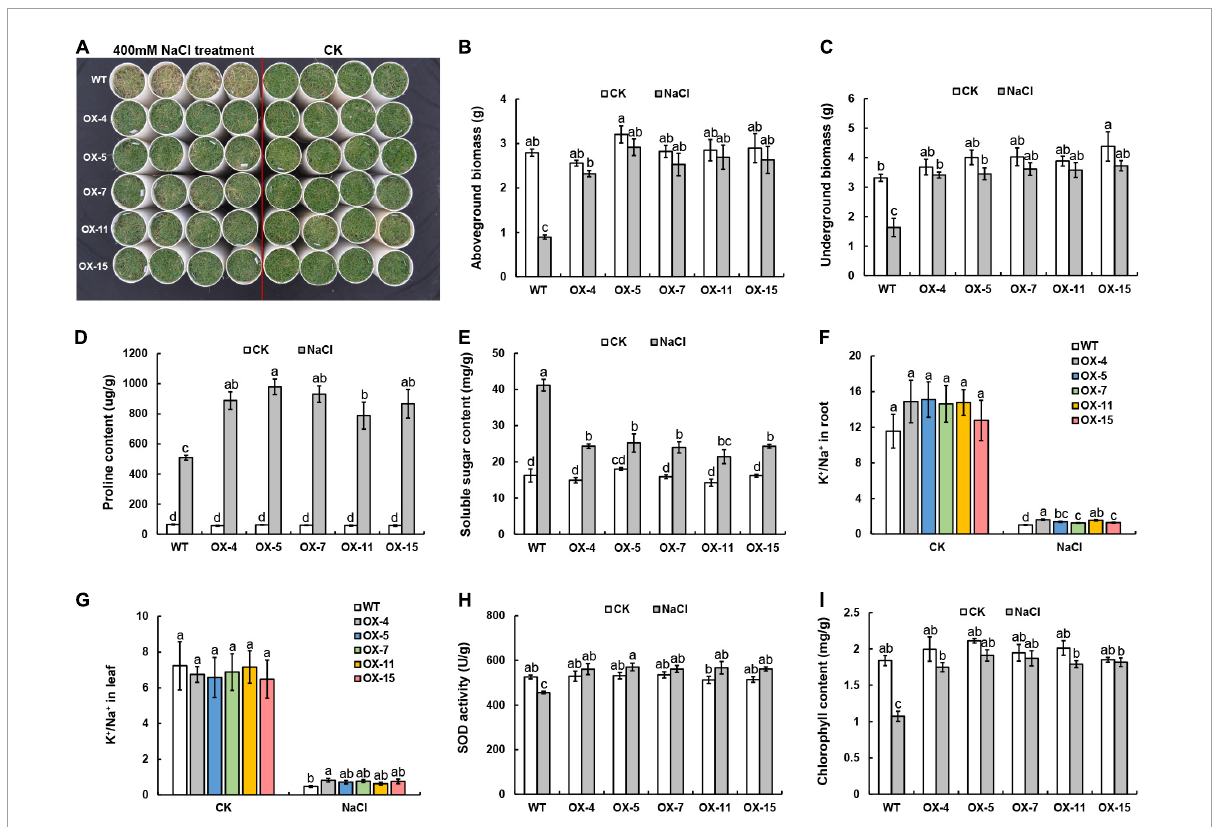
FIGURE1 Phenotypic and physiological responses to salt stress in OX-ZmPDI transgenic plants of Z. matrella. (A) OX-ZmPDI transgenic lines and wild-type (WT) plants were exposed to 400 mM NaCl and control (CK) treatments for 30 days. (B) The aboveground biomasses of OX-ZmPDI transgenic and wild-type plants after NaCl and CK treatments for 30 days. (C) The underground biomasses of OX-ZmPDI transgenic and wild-type plants after NaCl and CK treatments for 30 days. (D) The proline contents of OX-ZmPDI transgenic and wild-type plants after NaCl and CK treatments for 30 days. (E) The soluble sugar contents of OX-ZmPDI transgenic and wild-type plants after NaCl and CK treatments for 30 days. (F) The K + /Na + ratio in OX-ZmPDI transgenic and wild-type plant roots after CK and NaCl treatments. (G) The K + /Na + ratio in OX-ZmPDI transgenic and wild-type plant leaves after CK and NaCl treatments. (H) The chlorophyll contents of OX-ZmPDI transgenic and wild-type plants after NaCl and CK treatments for 30 days. (I) The SOD activity of OX-ZmPDI transgenic and wild-type plants after NaCl and CK treatments for 30 days. Values are presented as the mean ± SE. Letters above the bars indicate significant differences between the respective values ( p <